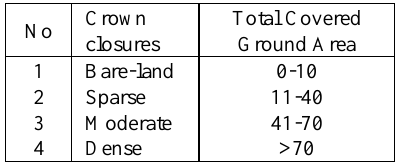
Table 3. Areal distribution (%) of crown closure